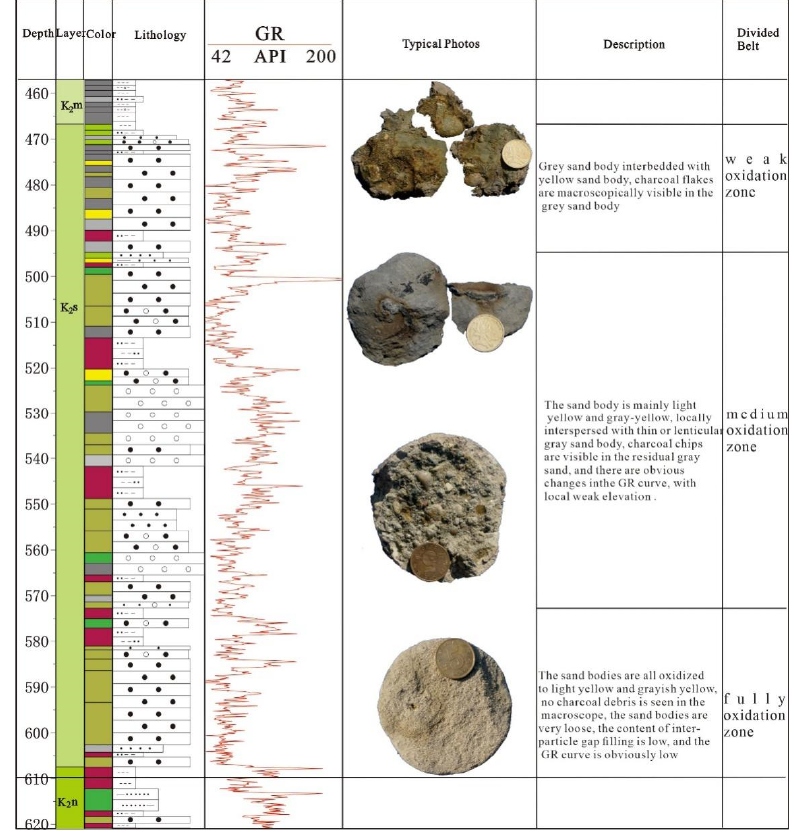
Figure 15. Development characteristics of oxidation zone in Sifangtai Formation of northern Songliao